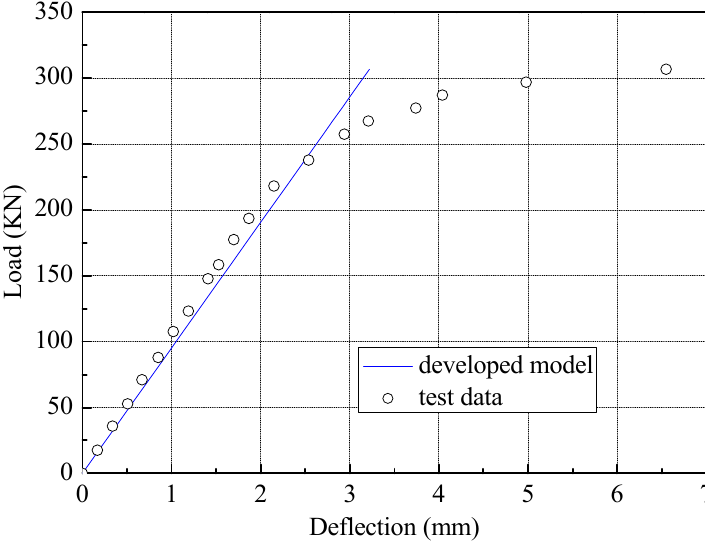
Figure 4. Load-deflection curves.